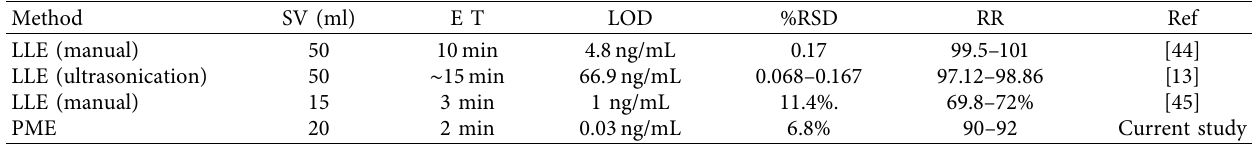
Table 2: Comparison of the methods reported in the literature for pregabalin.